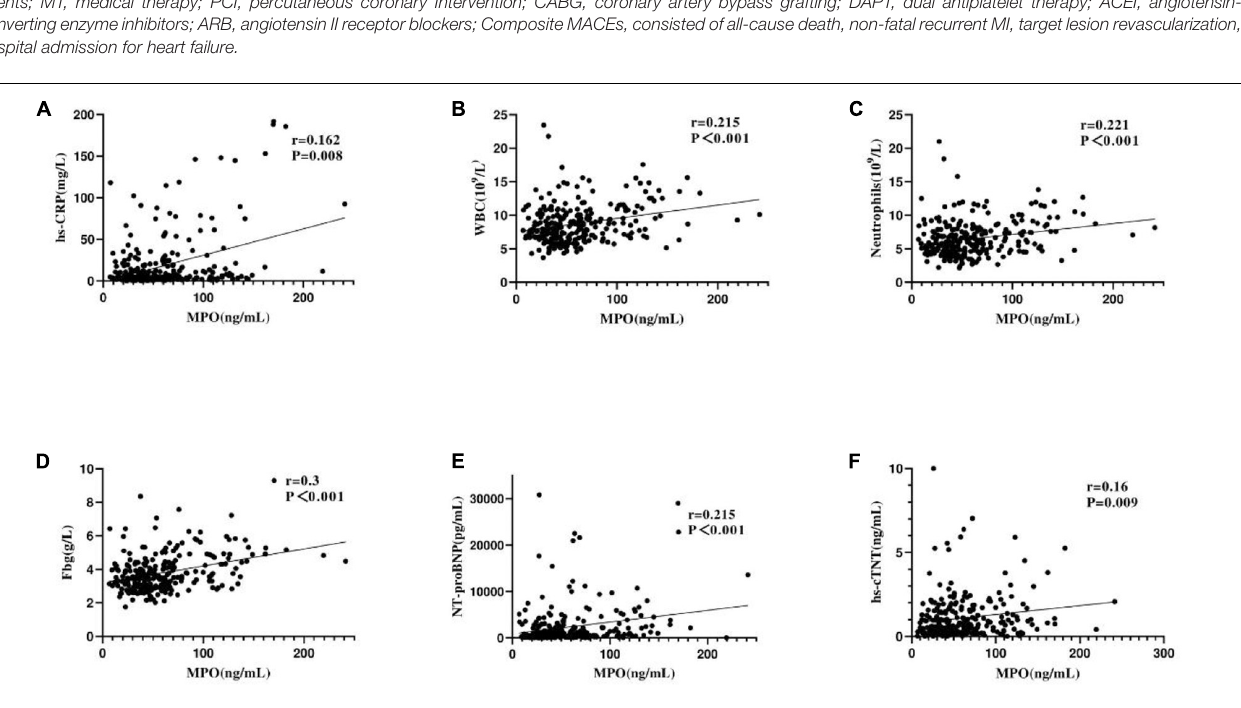
FIGURE 1 | Correlation between plasma MPO levels and other biomarkers. Panels (A–F) represent the correlation between plasma MPO levels and high-sensitivity C-reactive protein (hs-CRP), white blood cell (WBC) count, neutrophils, fibrinogen(Fbg), NT-proBNP, and hypersensitive troponin T (hs-cTNT). death showed a similarly significant upward trend (0 vs. 3.49 vs. 8.93%, P = 0.003). The incidence of target lesion revascularization MPO groups (12.5 vs. 3.49 vs. 3.10%, P = 0.03). The